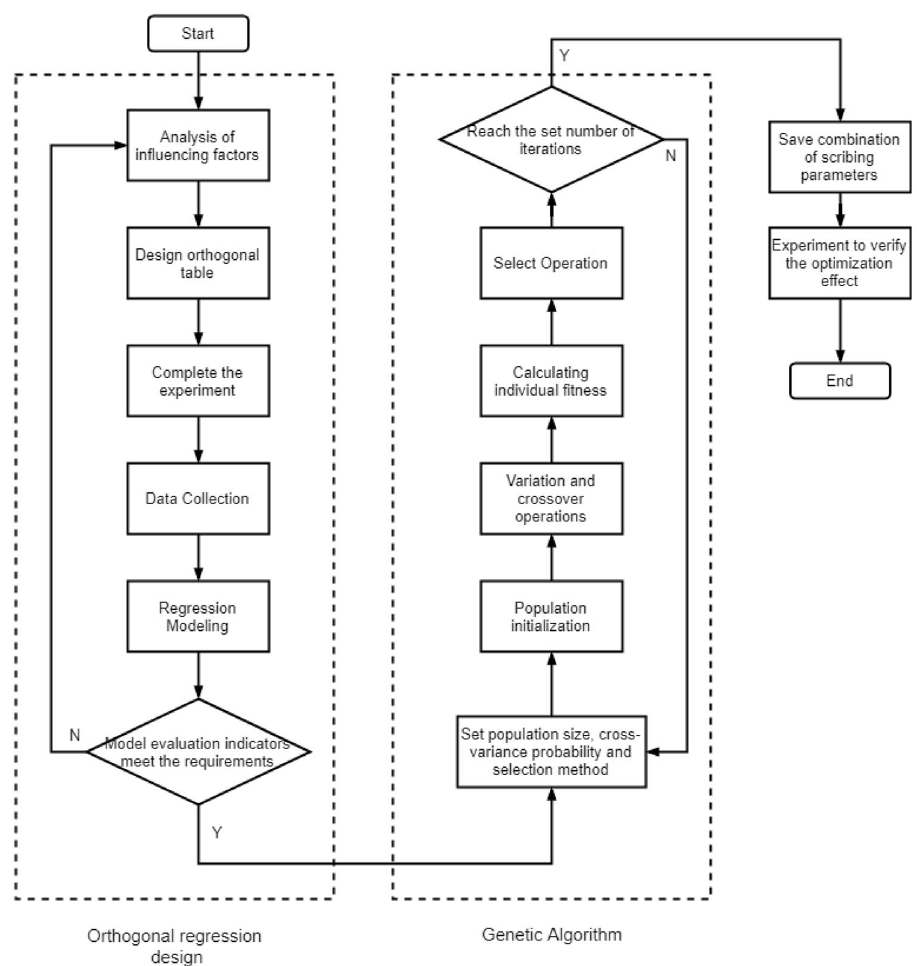
Fig. 1 Parameter optimization flow